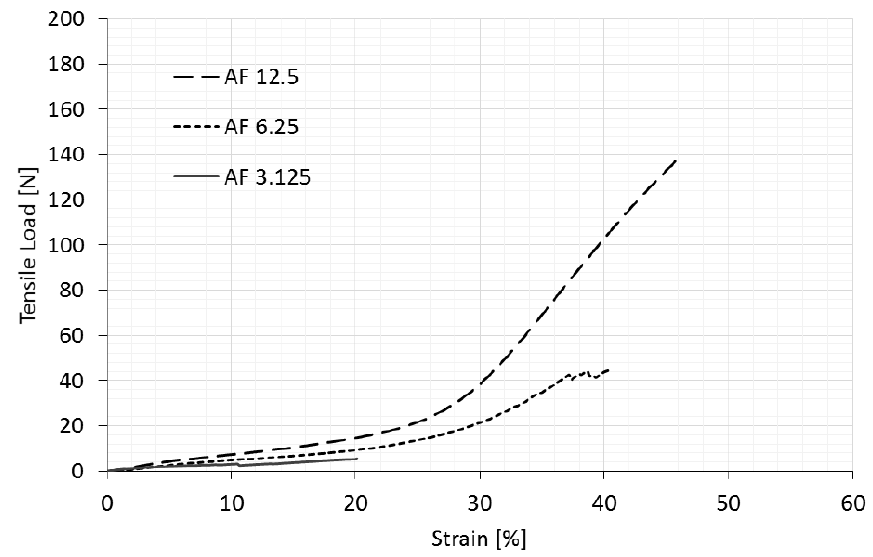
Figure 3. Tensile behavior of auxetic compound fabrics in the machine direction (longitudinal de- formation).